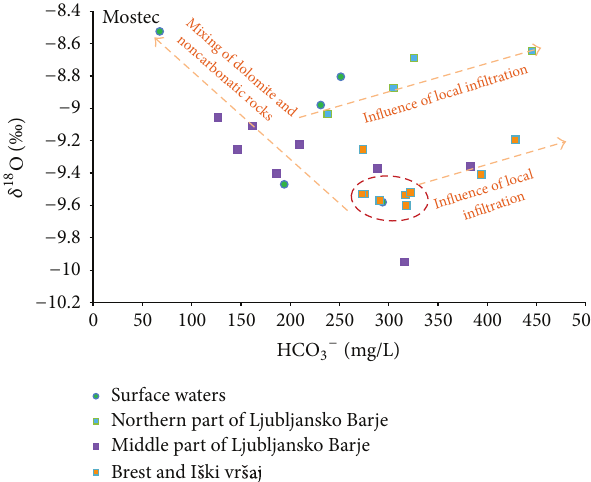
Figure8:RelationshipbetweenHCO 3− andisotopiccompositionof oxygen ( 𝛿 18 O) in groundwater of Ljubljansko polje and Ljubljansko Barje aquifers. Arrow shows direction of increasing altitude of recharge area.